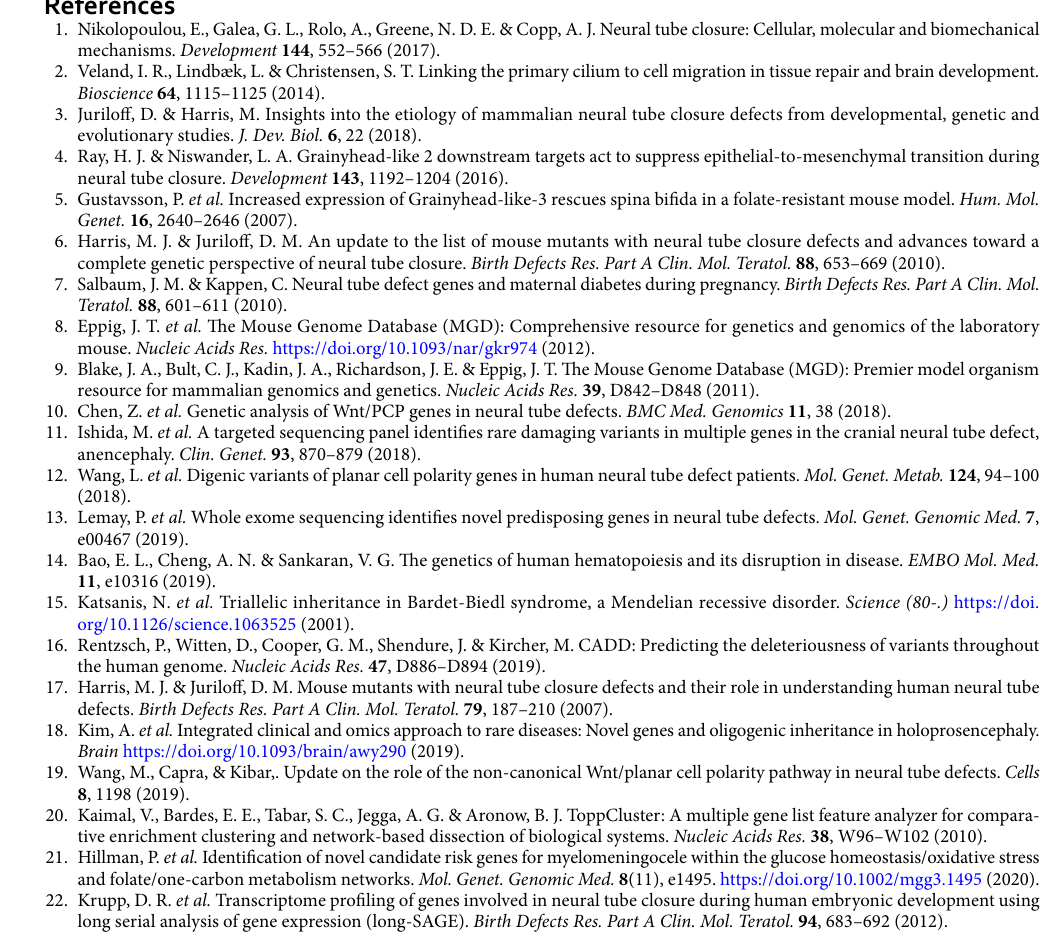
Table 2) was assembled from Mouse Genome Database 9 (http://www.infor matic s.jax.org/) using search terms: open neural tube (MP:00000929), exencephaly (MP:0000914), anencephaly (MP:0001890), craniorachischisis (MP:0008784), and abnormal neural tube closure (MP:0003720). Also included were RARA , RARG , KIAA0586 an d KATNAL2 with evidence of open neural tube defects in mice, chicken, frog and human 62–64 . Mouse NTD mutants not assigned to a gene and genes assigned only to spina bifida occulta were not included in this study. In addition, a list of 14 genes were added because association has been established in our study cohort (Supple- mentary Table 2). Together, a total of 551 candidate genes were selected for the